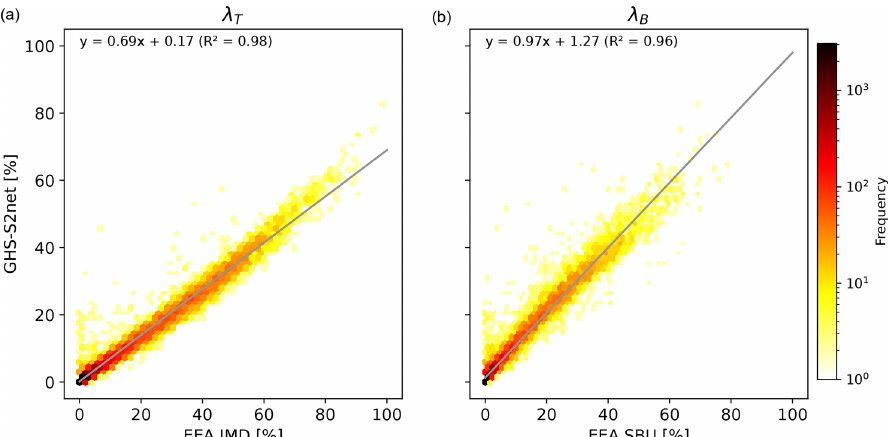
Figure D1. Hexbin illustration of the EEA imperviousness density (IMD, reflecting λ T ) and share of built-up (SBU, reflecting λ B ) against GHS-S2Net built-up probabilities for the European functional urban area (FUA) of Dortmund (Germany). Linear regression equations and R 2 values are provided for both λ T (a) and λ B (b) . The logarithmic colour bar represents the number of pixels in each imperviousness